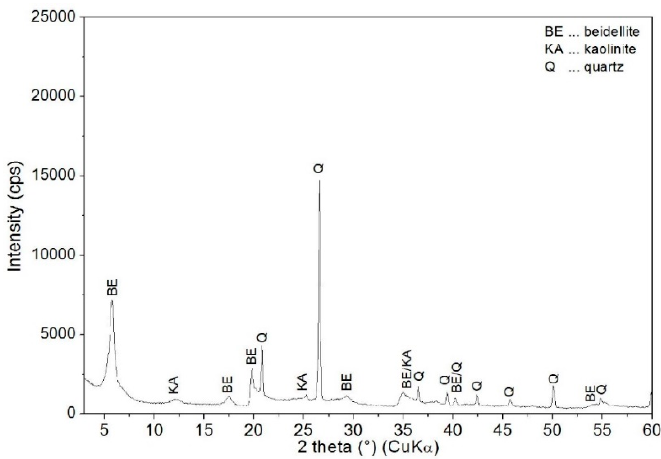
Figure 3. XRD pattern of unmodified BEI.